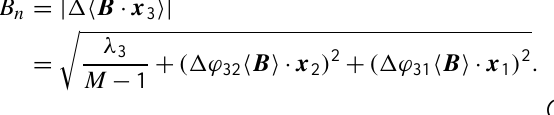
Fig. 2. Magnetic field time series and color-coded maps showing results from the MVAB analysis, for the 2003-018-1312 crossing (Event 1 in Tables 1 and 2) by C1 (left) and C3 (right). From top to bottom, the panels show B-field magnitude and components, thereafter maps of the eigenvalue ratio (EVR), the normal magnetic field B n , and its statistical uncertainty dB n . The color bar on the right applies to both C1 and C3. The white area in the bottom panels shows the location of the 20 nests with the lowest dB n within a 1/3-overlap cone that is indicated by the black lines (see text). The short black line within the white area marks the data interval with the lowest dB n . The B -traces in the upper two panels for C1 and C3 are shown with thicker lines for the interval spanning the 20 nest members.